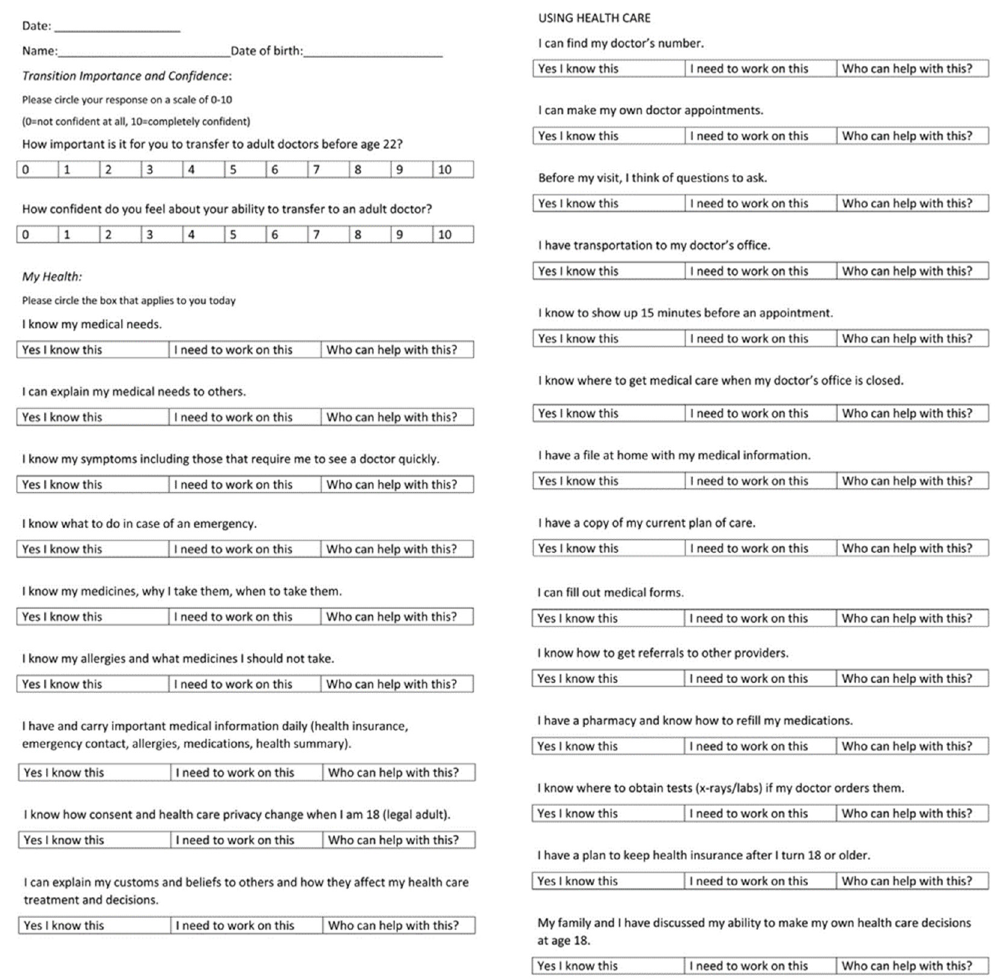
Figure 2. Questionnaire to access the patient’s readiness for the transition of care. Reprinted from Gasior A, Midrio P, Aminoff D, Stanton M. Ongoing care for the patient with an anorectal malfor- mation; transitioning to adulthood. Semin Pediatr Surg. 2020; 29(6): 150991, p. 2, with permission from Elsevier.